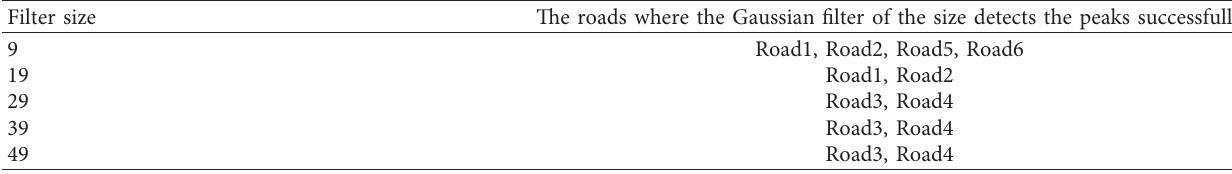
Table 2: The results of Gaussian filter of different sizes.